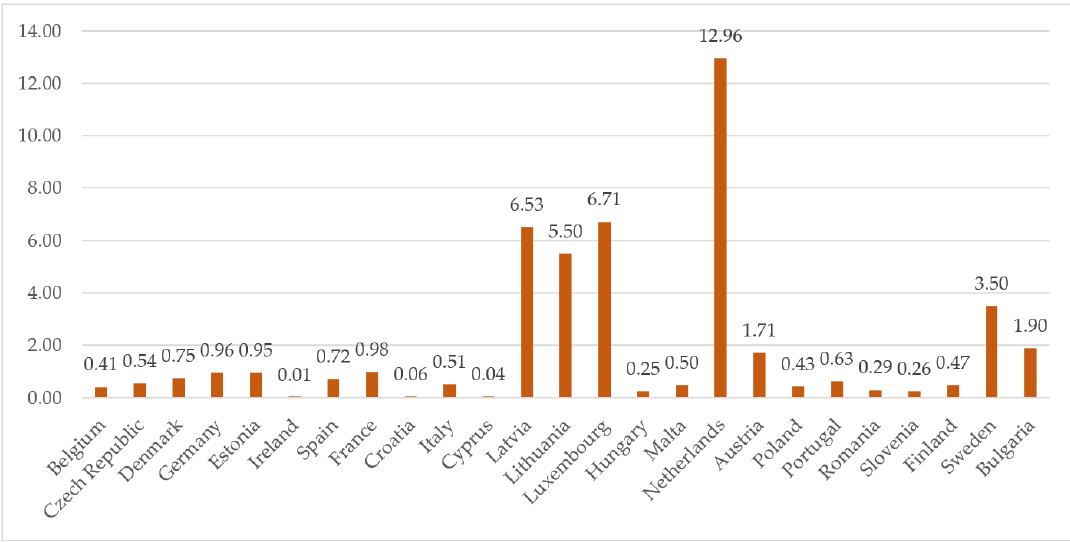
Figure 8. Motor coaches, buses and trolley buses by age in EU countries in 2020, %. Note: the data for Bulgaria, Greece and Slovakia are not available. Source: [74].